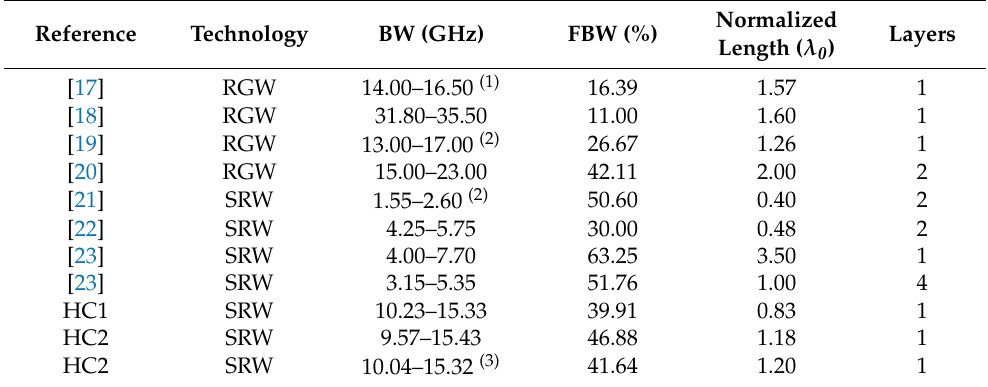
Table 3. Comparison with referenced